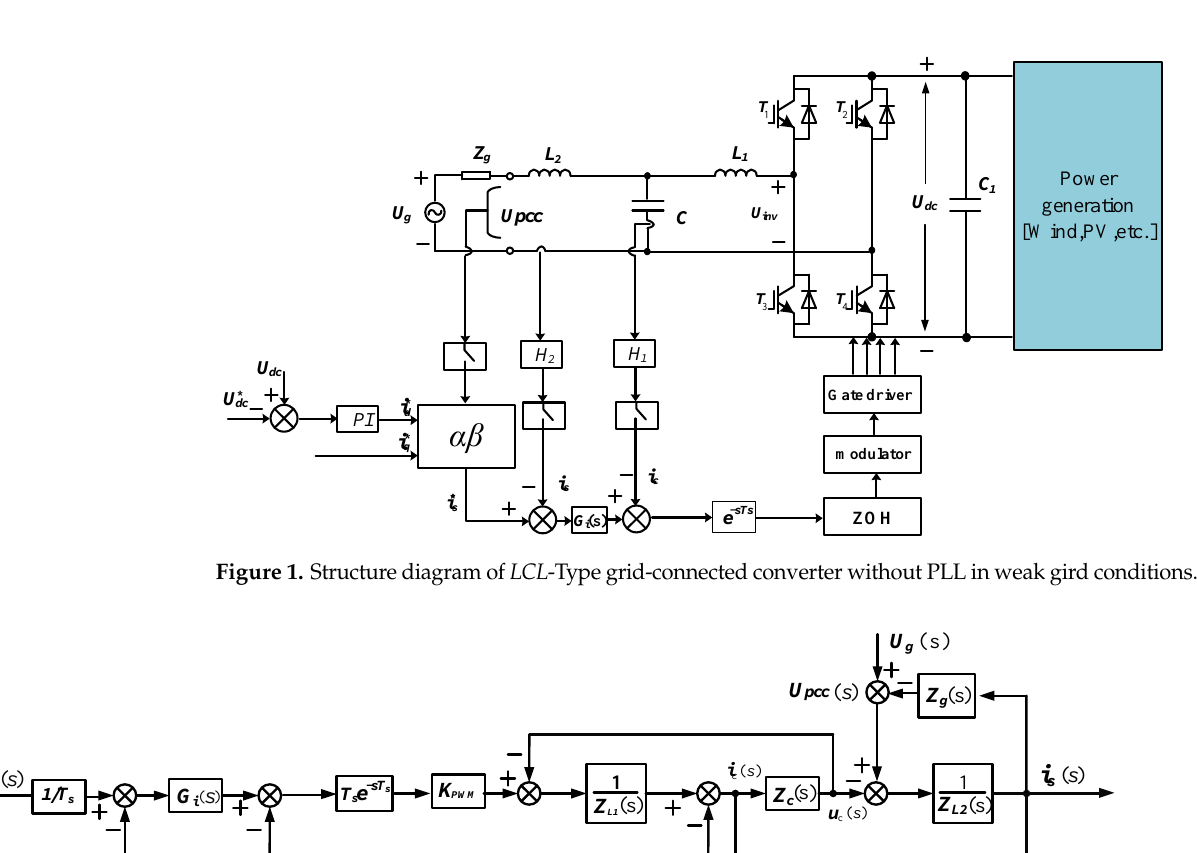
Figure 1. Structure diagram of LCL -Type grid-connected converter without PLL in weak gird con- ditions.